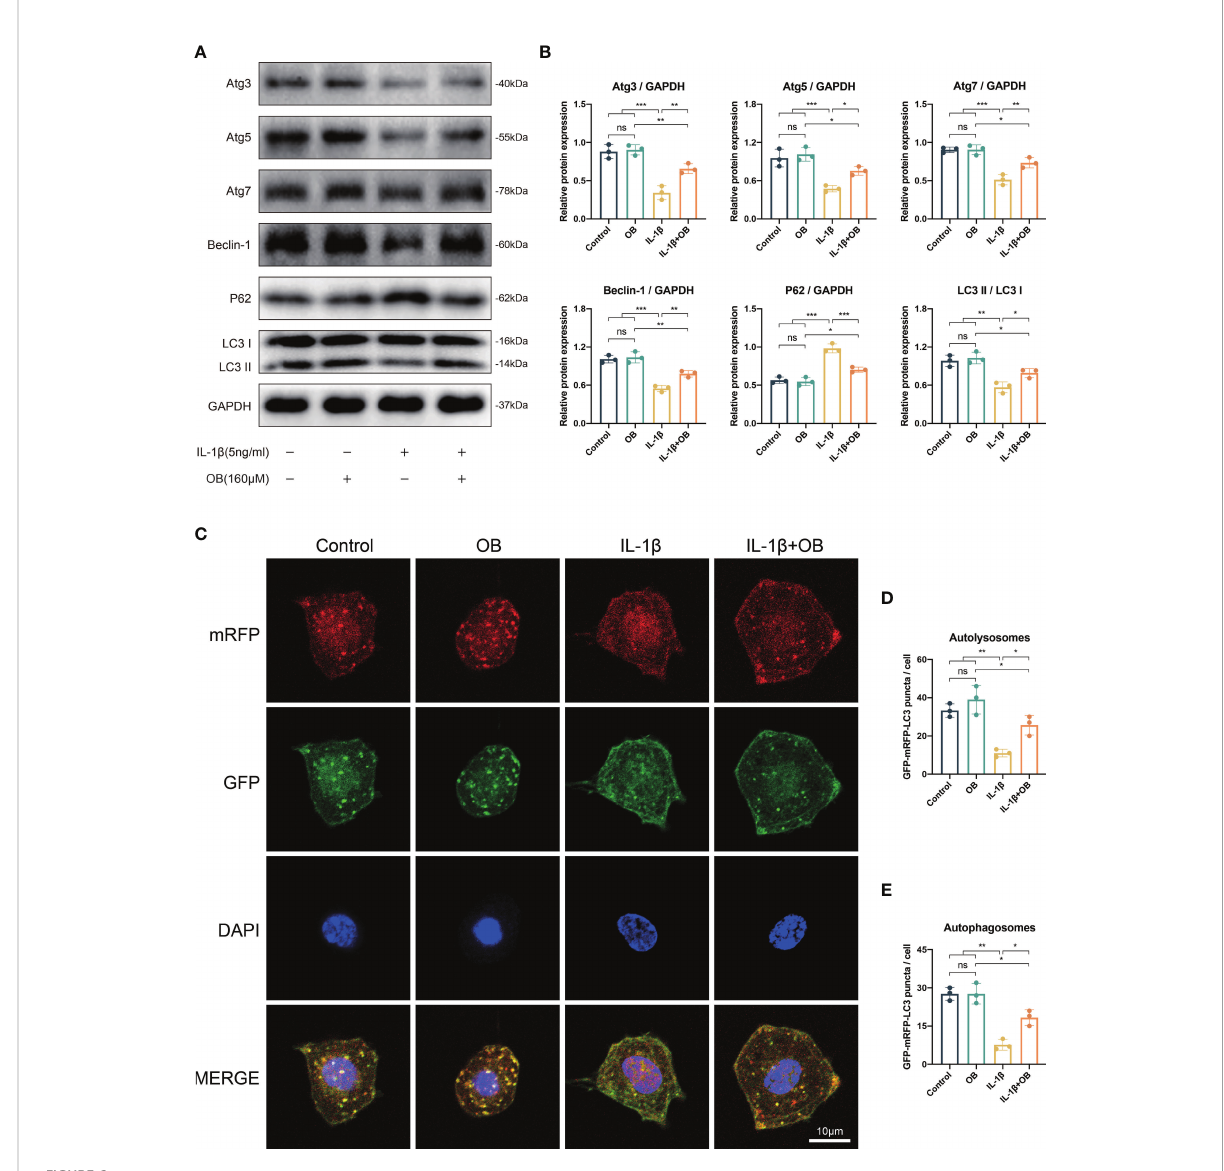
FIGURE 6 OB rescued the impaired autophagy process in IL-1 b – induced chondrocytes. Chondrocytes were administered with IL-1 b (5 ng/ml) or/and OB (160 m M) for 24 h. (A) Western blot and (B) quantitative analysis showed the impaired autophagy induced by IL-1 b could be rescued by the treatment of OB (160 m M). (C) Chondrocytes were transfected with tandem GFP-RFP-LC3 adenovirus, and the strength of autophagic fl ux was captured with a confocal microscope. (D, E) Quantitative analysis of autolysomes (red puncta) and autophagosomes (yellow puncta) among groups. Data were presented as means ± SD (n = 3). ns, no signi fi cance; *p < 0.05; **p < 0.01; ***p <